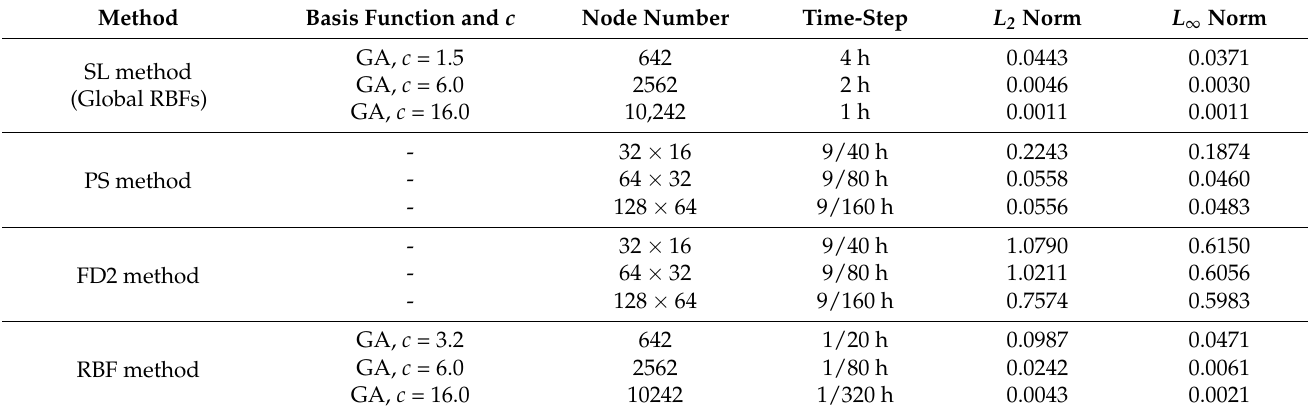
Table 3. Comparison results between the proposed SL method, the PS method, FD2 method, and RBF method under different space